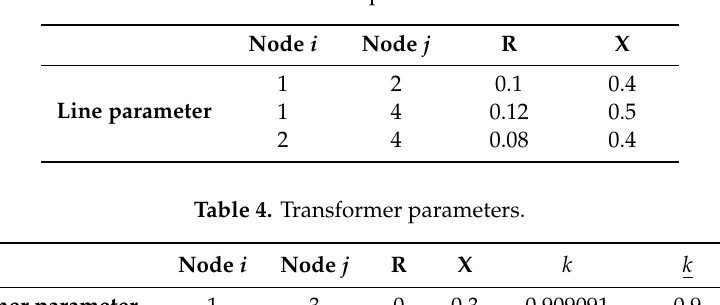
Table 3. Line parameters.